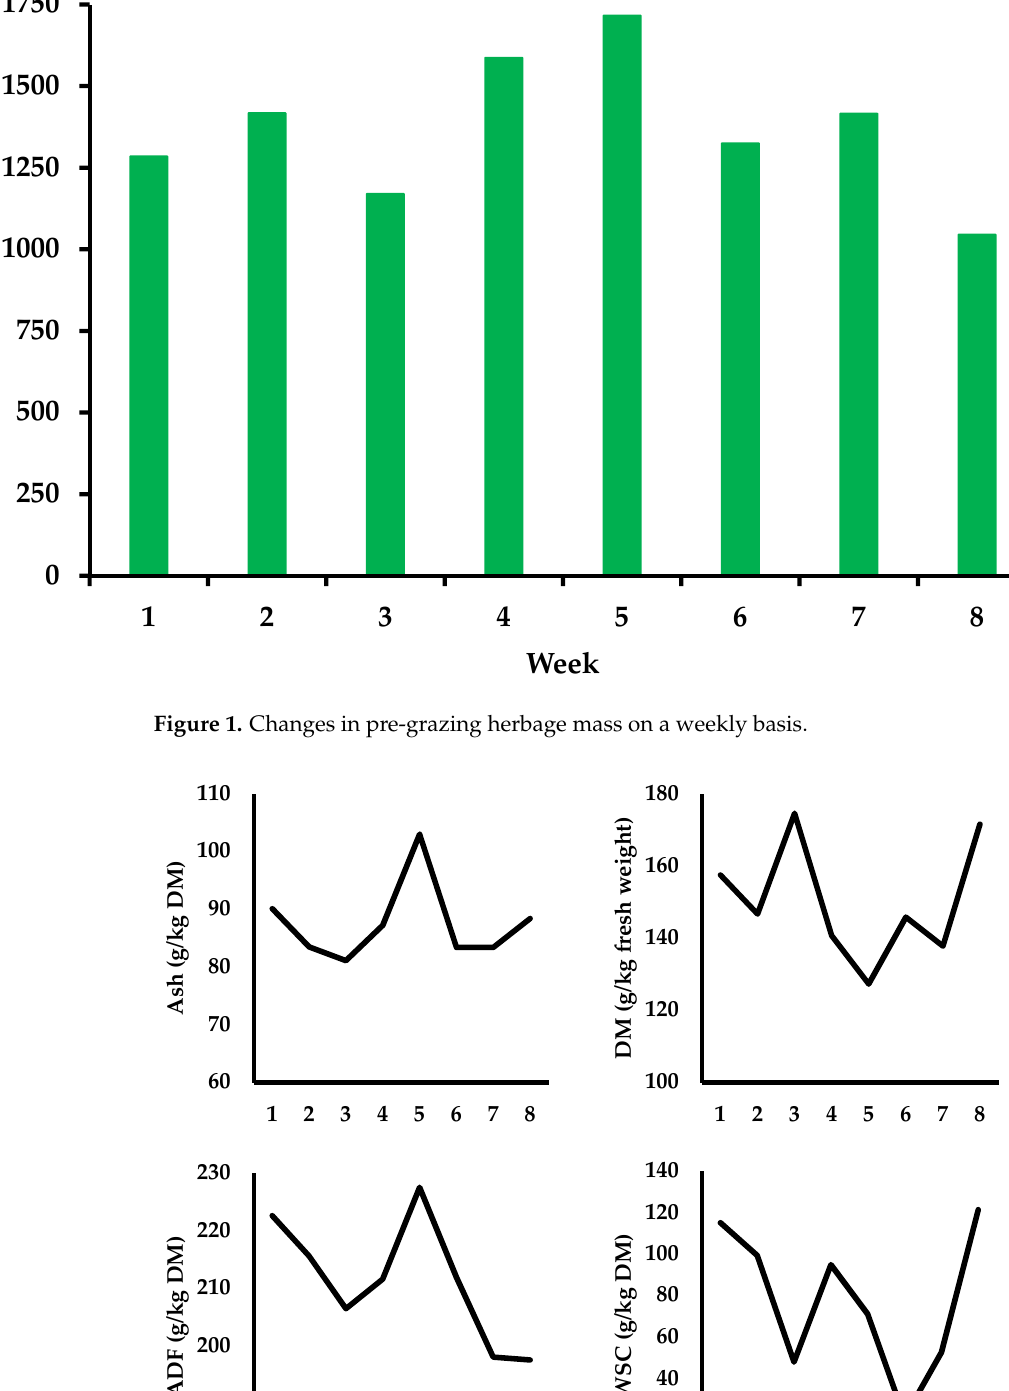
Figure 2. Changes in autumn herbage quality offered to dairy cows during the experiment (week 1 = September 9 and week 8 = October 28). A nitrogen partitioning study was conducted during week 2. Standard deviations across the 8-week experimental period were: ±6.5 g ash/kg DM; ±15.4 g DM/kg of FW (fresh weight); ±10.0 g ADF/kg DM; ±33.2 g WSC/kg DM; ±38.3 g NDF/kg DM; and ±32.5 g CP (crude protein)/kg DM. 2.4. Data and Sample Collection 2.4.1. Herbage and Concentrate On a daily basis, herbage samples were collected using the “quadrant and shears” method [22]. Then, on a weekly basis, daily herbage samples were pooled for chemical analyses. Concentrate samples were collected weekly for DM and then ground for anal- yses. 2.4.2. Milk Cows were milked twice daily at 700 h and 1500 h. Milk output was recorded, and milk sampling was facilitated using the Weighall milk metering and sampling system (Dairymaster, Kerry, Ireland). Milk samples were taken from a successive am and pm milking once per week for each cow. The ratio of am milk to pm milk used in a cow’s milk